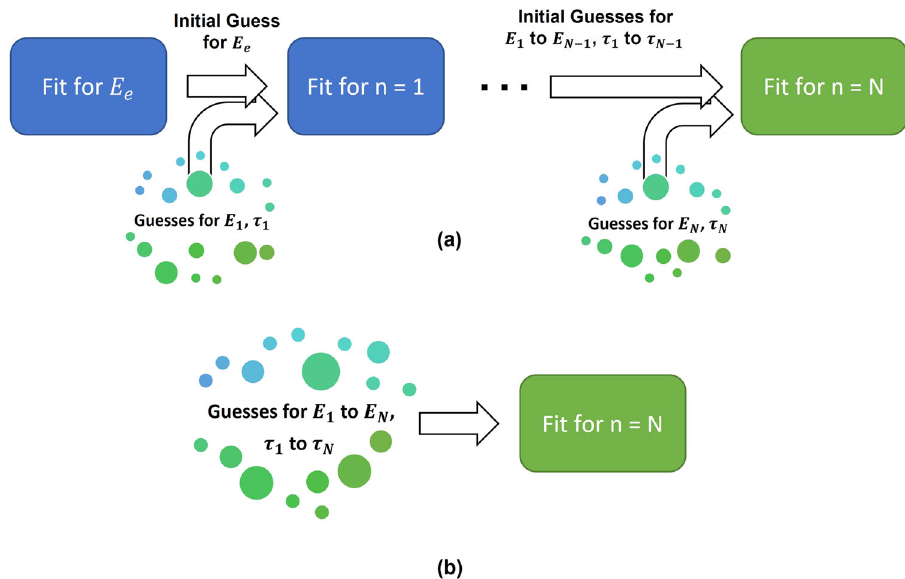
Fig. 1 Flowchart comparison for the iterative and open-search methodologies. The process visualization for the iterative- fi tting ( a ) and open-search ( b ) methodologies are shown here, using increasingly more complex con fi gurations within a generalized viscoelastic model (see Fig. 2f). As depicted, the iterative- fi tting methodology involves slowly expanding the desired generalized viscoelastic model while iteratively re-parameterizing each new con fi guration. The “ optimal ” parameter set for a given con fi guration is used as the initial guess in the next fi tting attempt. In this scheme, a random starting point is generated only for the new parameters. In the open-search methodology, there is no a priori information provided to the parameterization process, aside from the valid parameter bounds and a random initial guess for each parameter in the model. The variable “ N ” represents the N th element introduced into the generalized viscoelastic